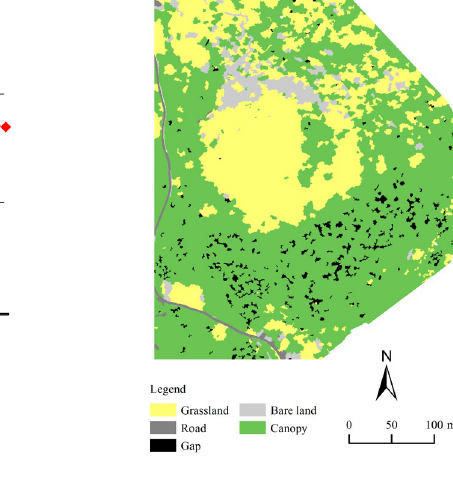
Figure 5. Results of the canopy segmentation under different shape and compactness parameters. The order of parameters is segmentation scale/shape/compactness. Red outlines represented the canopy contours formed by multi-scale segmentation. Visual interpretation of the overlap between the segmented outlines in red and the canopy shape of the original image. A high overlap indicated a good segmentation effect. If multiple canopies are within a red outline, it means under-segmentation; if a canopy is segmented by multiple red outlines, it means over-segmentation.